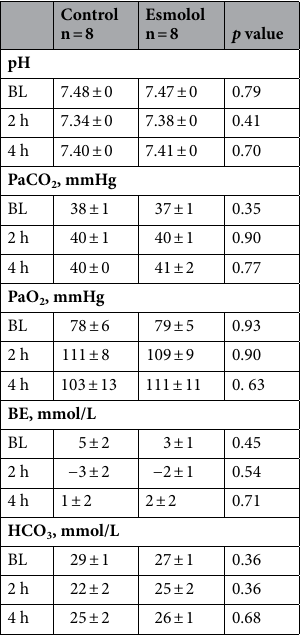
Table 1. Hemodynamics and arterial blood gas analysis. Data are expressed as mean ± SEM. p values refer to Sidak’s post hoc correction for multiple comparisons. BL, baseline; LV, left ventricle; PaO 2 , arterial partial pressure of oxygen; PaCO 2 , arterial partial pressure of carbon dioxide; BE, base excess.